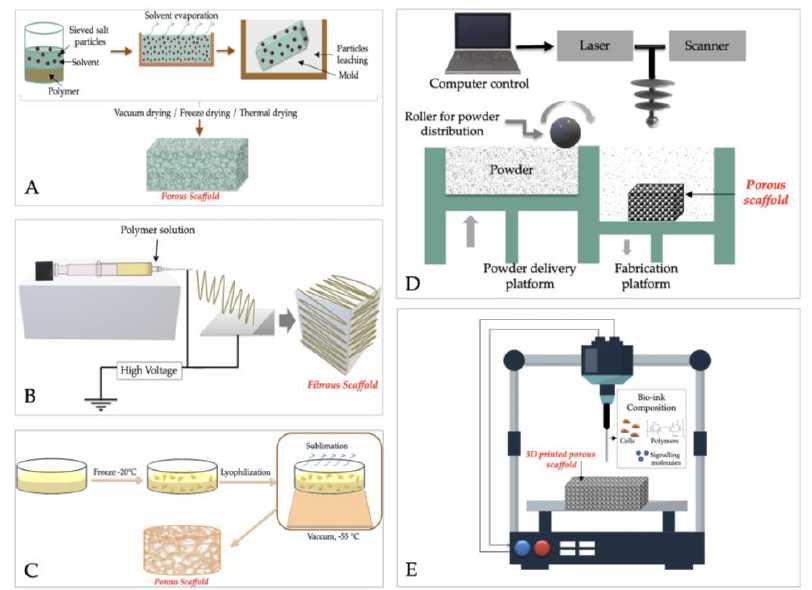
Figure 5. Conventional and modern techniques for designing bone tissue engineered scaffolds. ( A ) Solvent-casting/particulate leaching techniques; ( B ) Lyophilization; ( C ) Electrospinning; ( D ) SLS